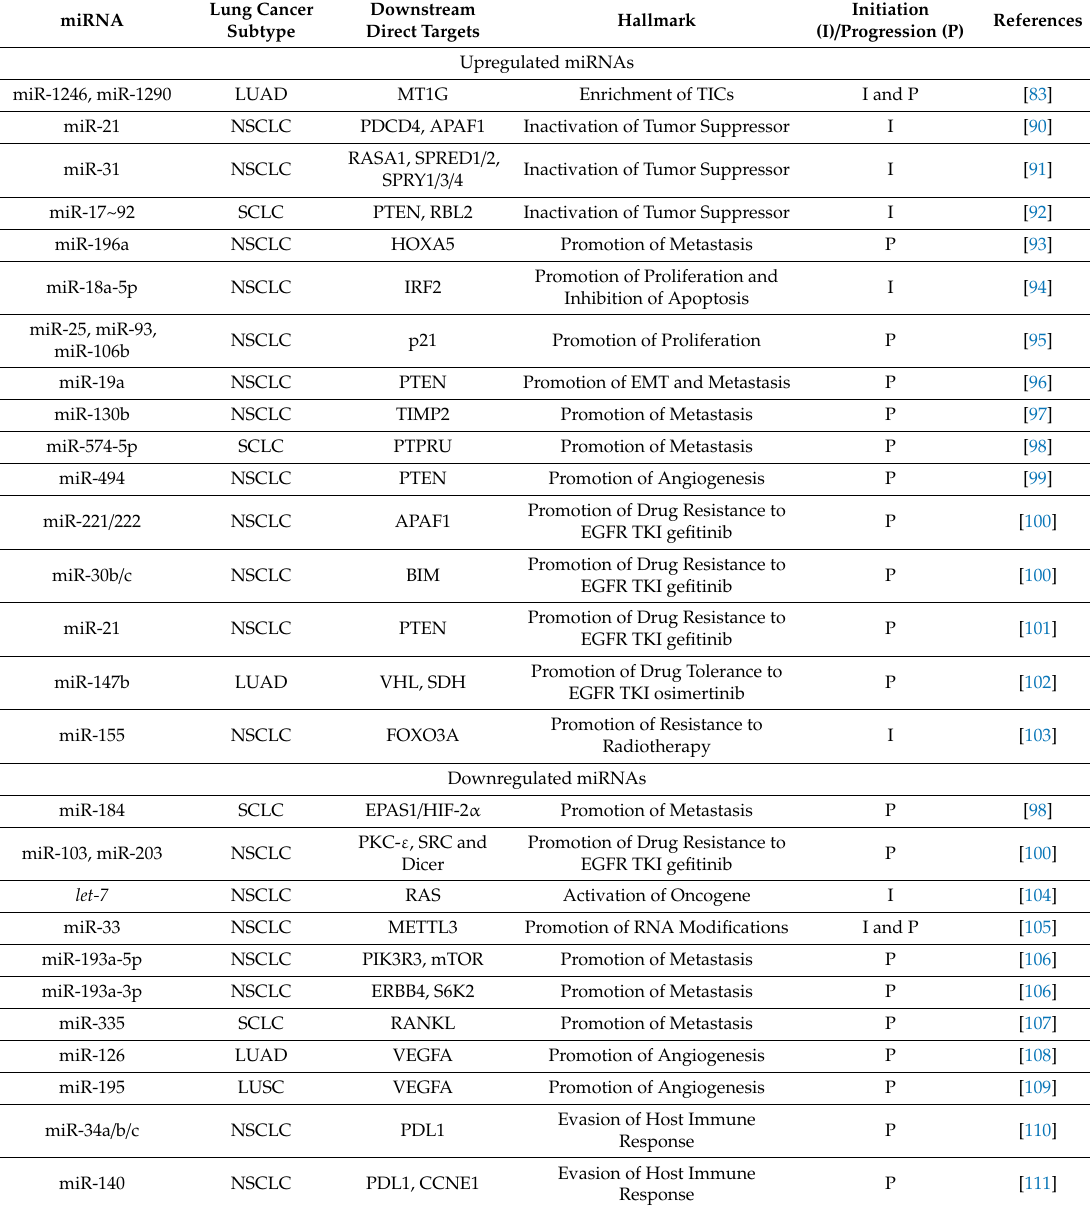
Table 1. miRNAs involved in lung cancer initiation and